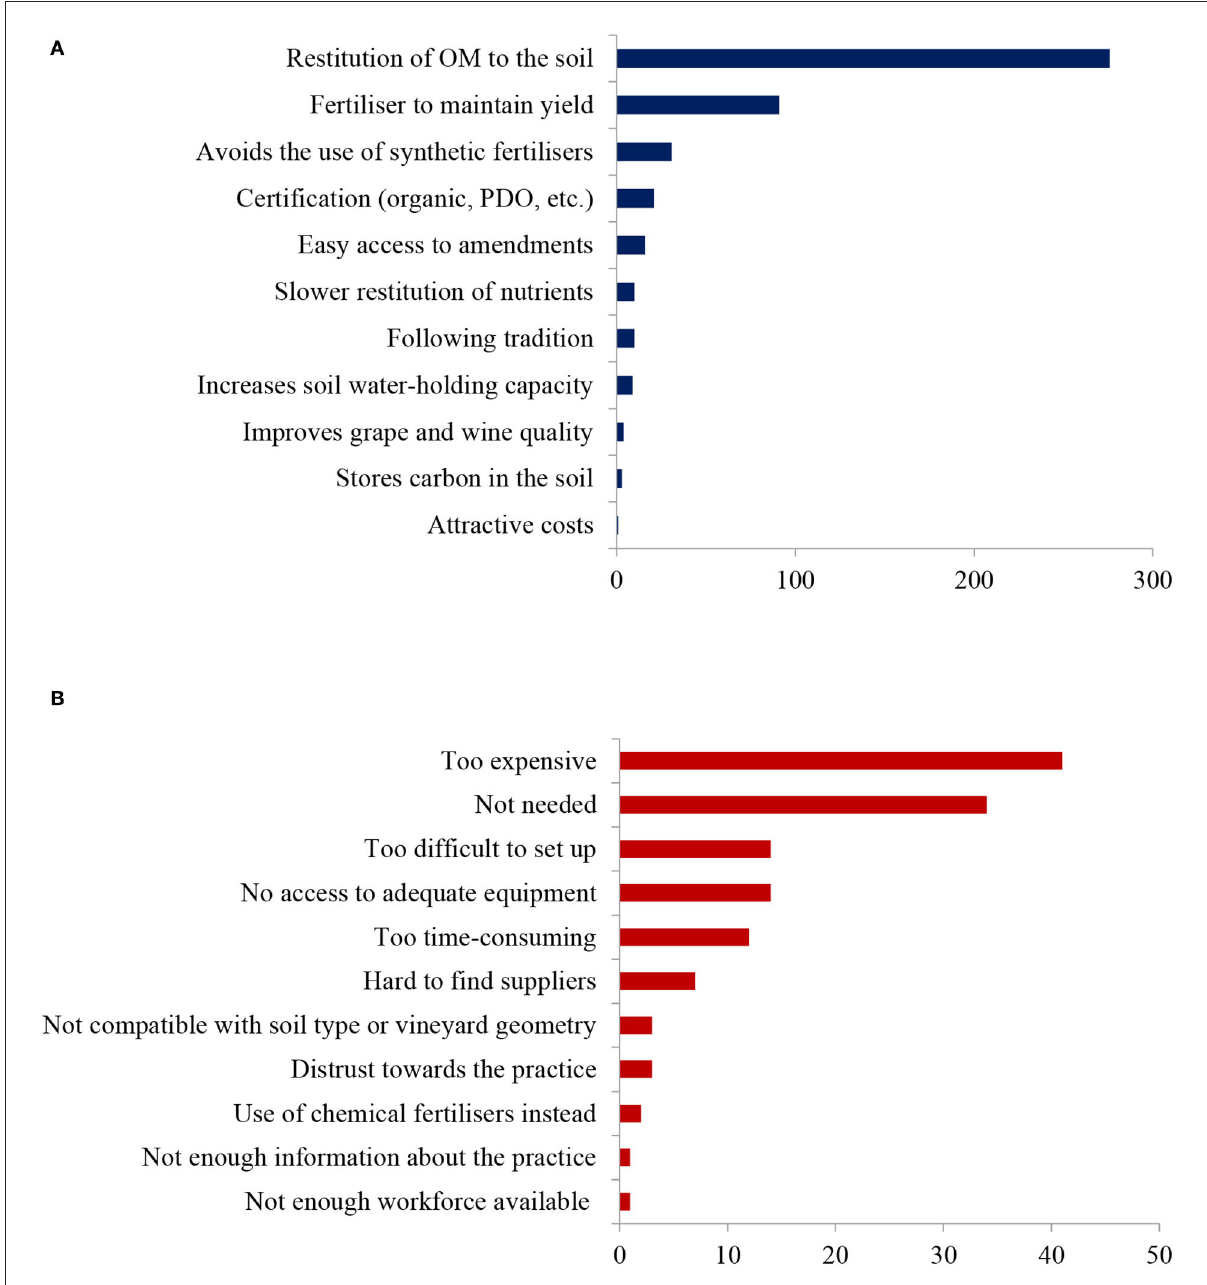
FIGURE1 Motives (A) and barriers (B) to the adoption of organic amendments in viticulture in France ( n = 341 and 107, respectively). Several responses were possible for each respondent. OM, organic matter; PDO, protected designation of